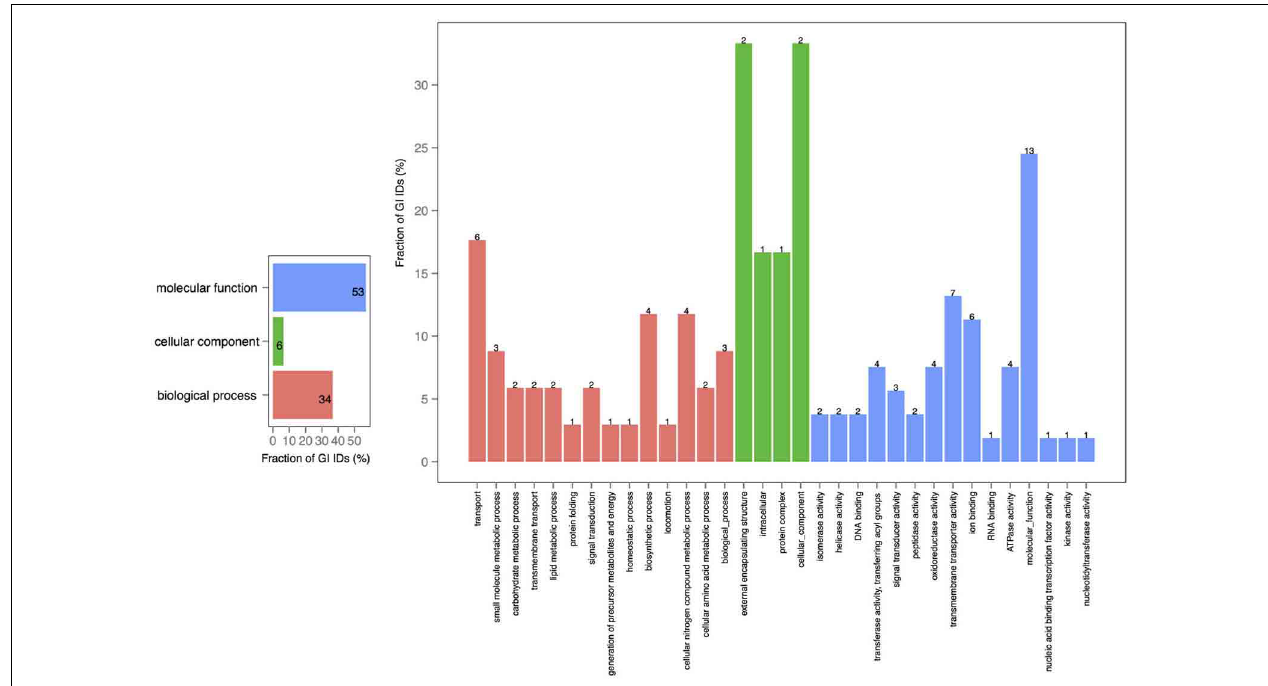
FIGURE 3 | GO term analysis in proteins shared by chromosomes 1 and 2. The distribution is shared both as percentage on the axis and the absolute number above the bar. The absolute number reflects the amount of